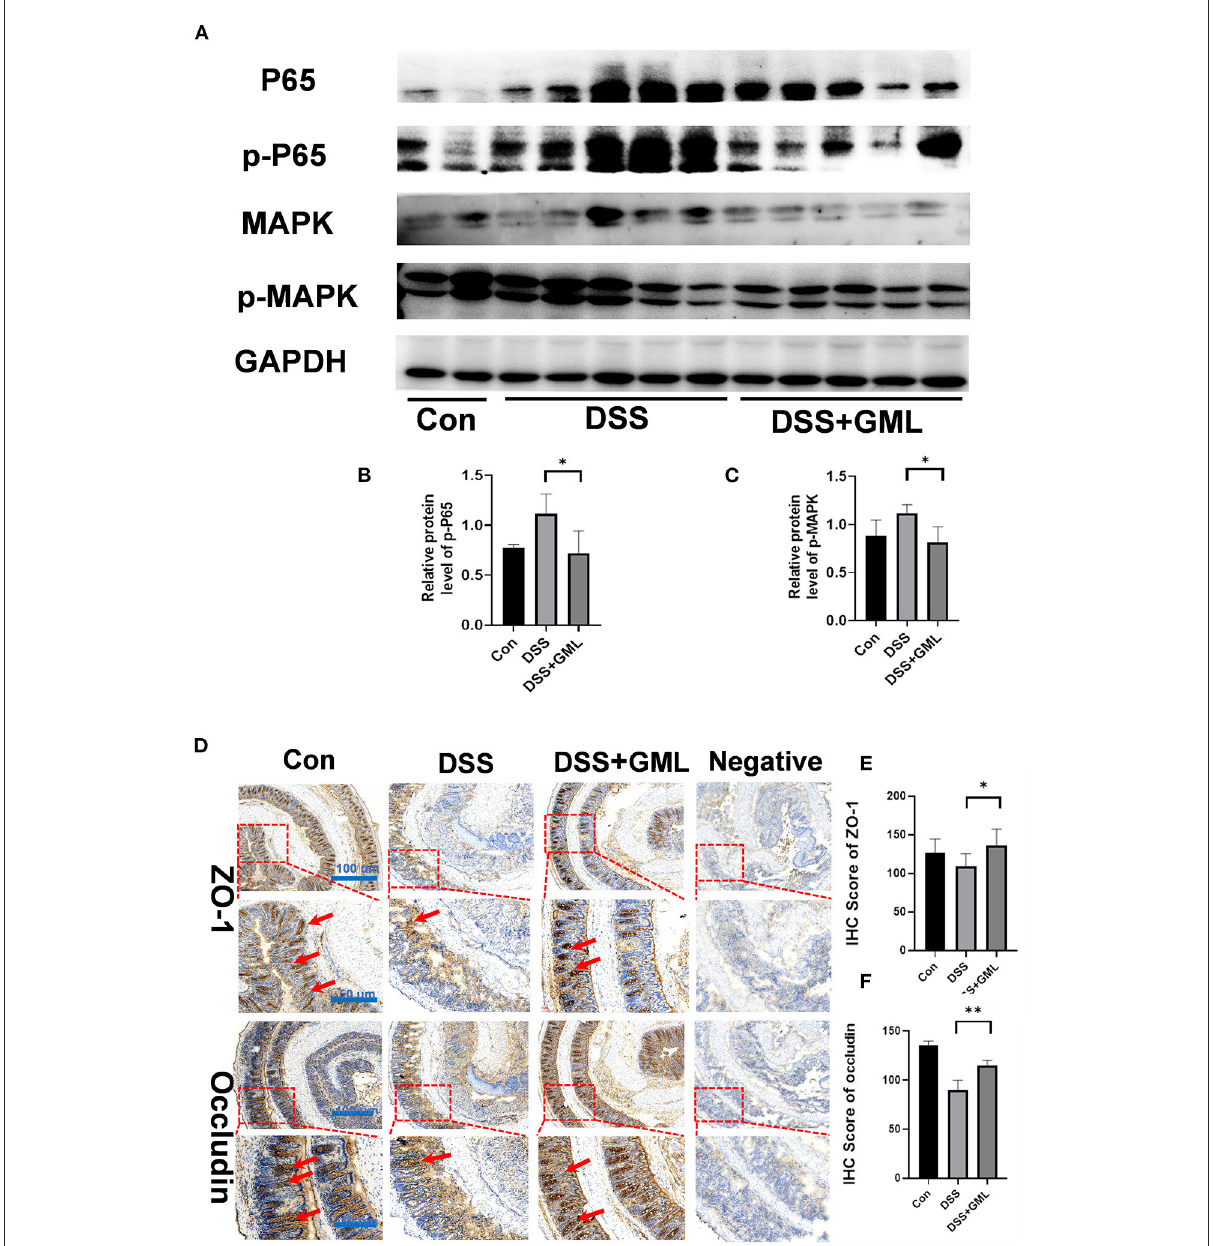
FIGURE3 GML treatment inhibited the NF- κ B and MAPK signalling pathways and attenuated DSS-induced damage to tight junctions in the colon tissues. (A) Representative protein bands for p-p65, p65, p-MAPK, and MAPK. (B,C) Statistical analysis of protein bands. (D) Immunohistochemistry results (ZO-1 and Occludin). (E,F) Statistical analysis ZO-1 of IHC score. (F) Statistical analysis occludin of IHC score. The data are expressed as the means ± SDs ( n = 5). * P < 0.05; ** P < 0.01.